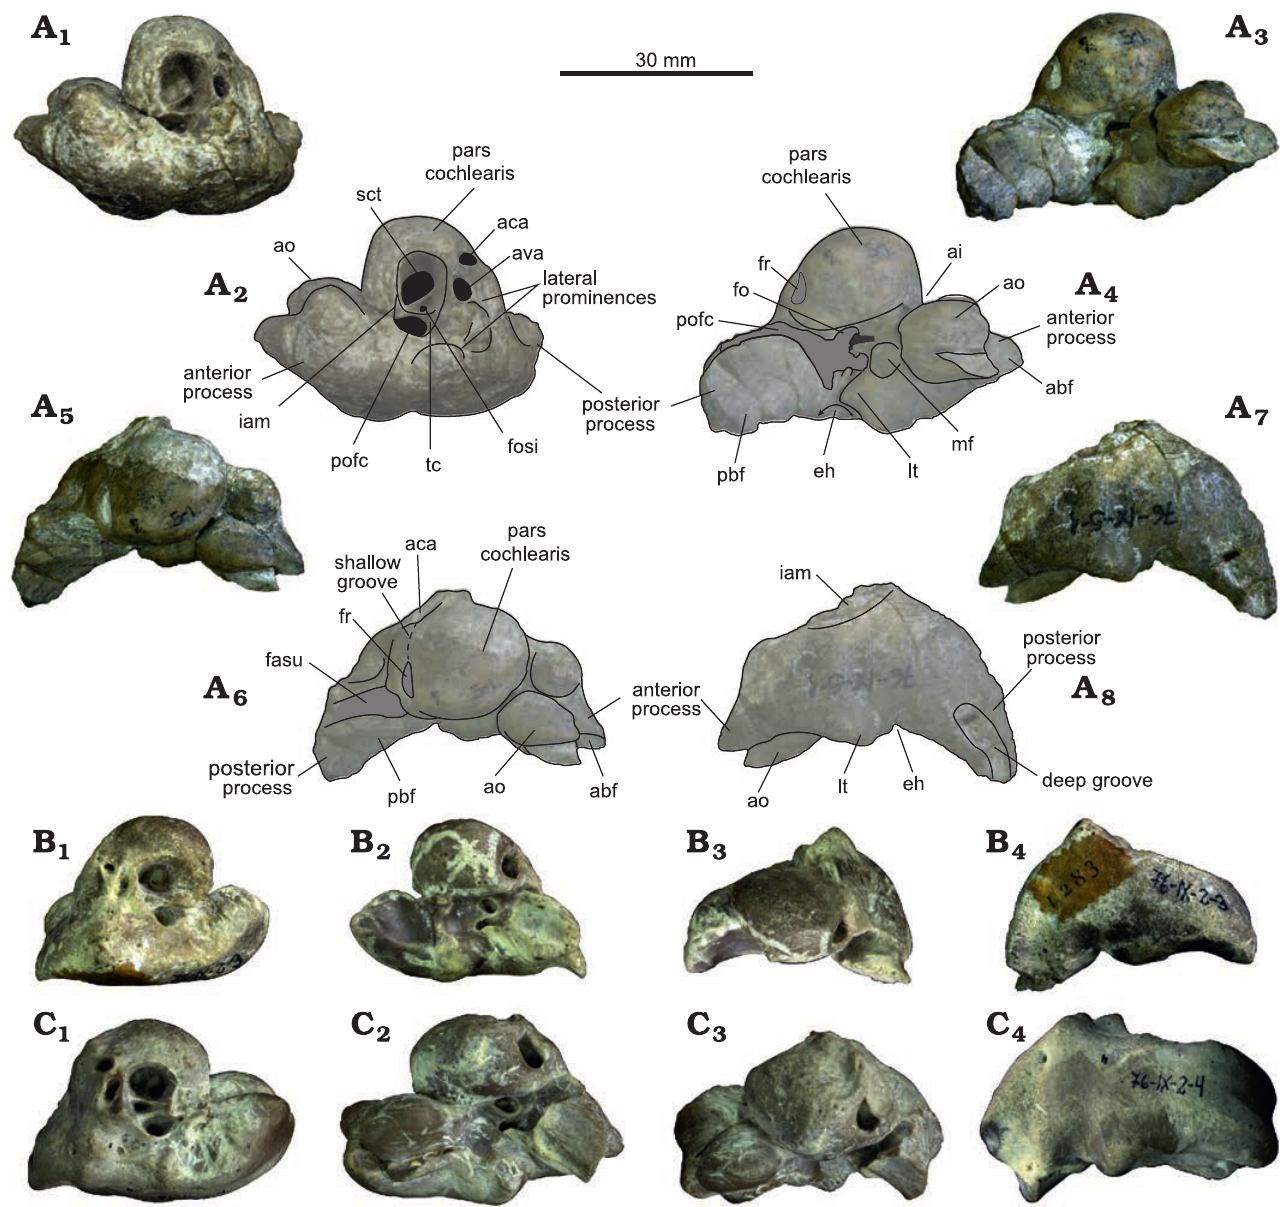
Fig. 3. Sperm whale Physeteroidea indet. A . Left periotic of nomen dubium “ Preaulophyseter gualichensis ” Caviglia and Jorge, 1980, MLP 76-IX-5-1, from the Miocene of Gran Bajo del Gualicho Formation, Patagonia, Argentina, in dorsal (A 1 , A 2 ), ventral (A 3 , A 4 ), medial (A 5 , A 6 ), and lateral (A 7 , A 8 ) views. B , C . Two isolated right periotics from the Miocene of Patagonia, MLP 76-IX-2-3 ( B ) and MLP 76-IX-2-4 ( C ), in dorsal (B 1 , C 1 ), ventral (B 2 , C 2 ), medial (B 3 , C 3 ), and lateral (B 4 , C 4 ) views. Photographs (A 1 , A 3 , A 5 , A 7 , B, C) and explanatory drawings (A 2 , A 4 , A 6 , A 8 ). Abbreviations: abf, anterior bullar facet; aca, aperture for cochlear aqueduct; ai, anterior incisure; ao, accessory ossicle; ava, aperture for the vestibular aqueduct; eh, epitympanic hiatus; fasu, facial sulcus; fo, fenestra ovalis; fosi, foramen singulare; fr, fenestra rotunda; iam, internal acoustic meatus; lt, lateral tuberosity; mf, mallear fossa; pbf, posterior bulla facet; pofc, proximal opening of facial canal (VII); sct, spiral cribiform tract